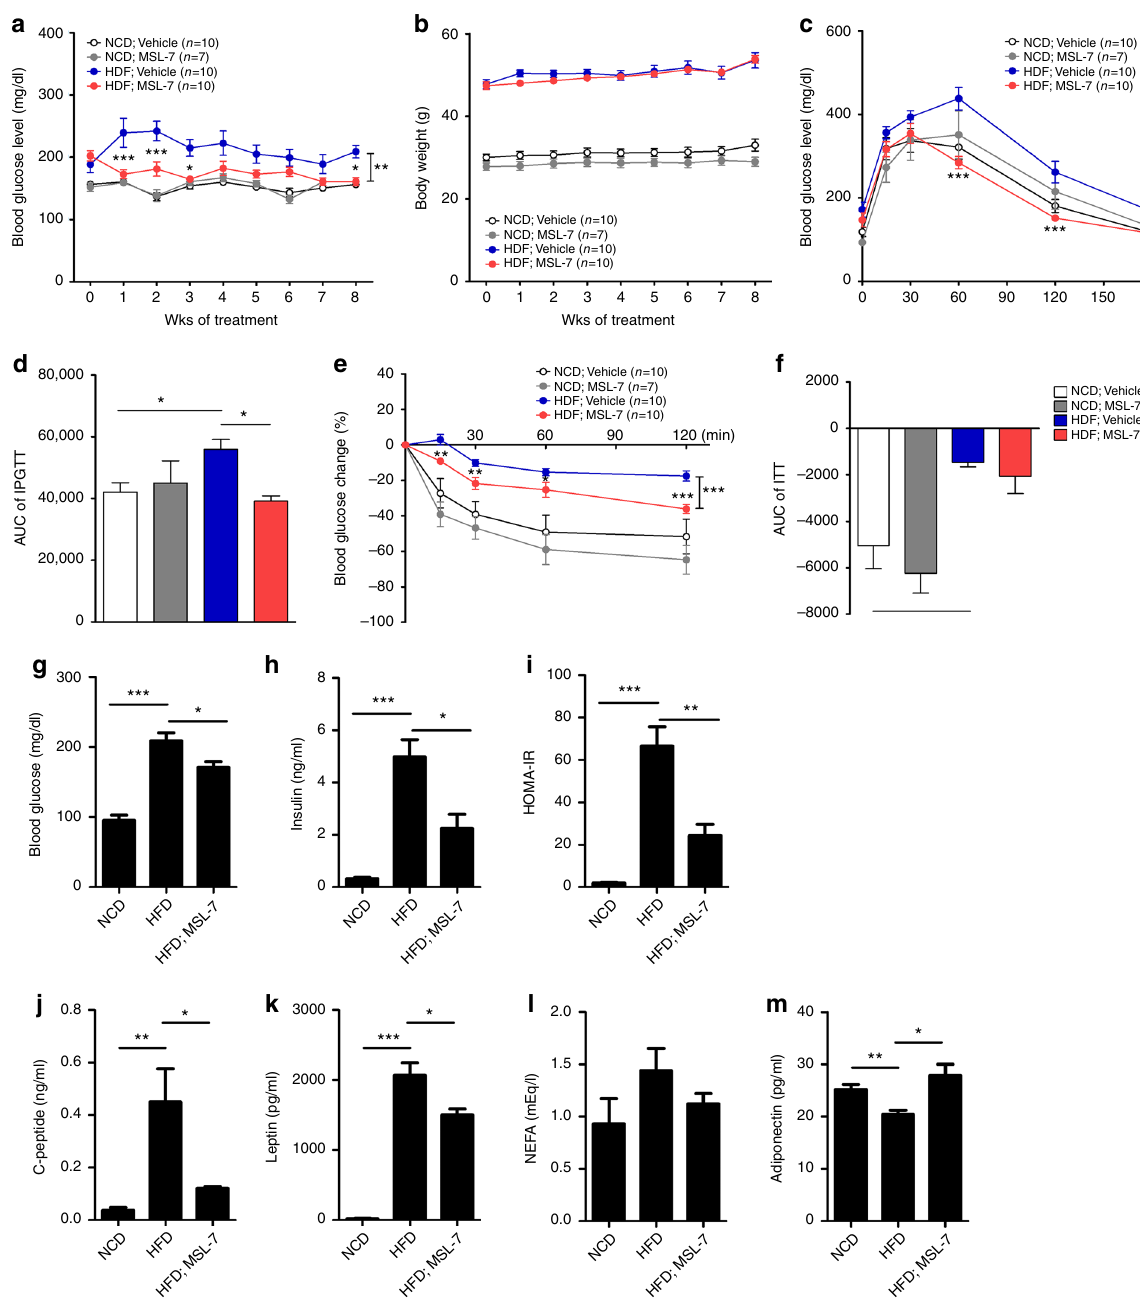
Fig. 6 Improved metabolic pro fi le of HFD-fed mice after administration of chemically modi fi ed autophagy enhancer, MSL-7. a , b Eight-week-old male C57BL/6 mice were fed HFD or normal chow diet (NCD) for 8 weeks, and then treated with 50 mg/kg MSL-7 3 times a week for 8 weeks. Nonfasting blood glucose level ( a ) and body weight ( b ) were monitored ( F = 56.5, df = 1 for a ). c IPGTT was conducted after in vivo administration of MSL-7 for 8 weeks ( F = 52.7, df = 1). d AUC of the IPGTT curve in c ( F = 4.2, df treatment = 3, df residual = 33). e ITT was conducted after in vivo administration of MSL-7 for 8 weeks ( F = 52.6, df = 1). f AUC of the ITT curve in e ( F = 10.3, df treatment = 3, df residual = 33). g – m Metabolic parameters of mice treated with MSL-7. Fasting blood glucose level ( g ) and serum levels of insulin ( h ), C-peptide ( j ), leptin ( k ), NEFA ( l ), and adiponectin ( m ) were determined. HOMA-IR was calculated ( i ). All data in this fi gure are the means ± s.e.m. from ≥ 3 independent experiments performed in triplicate. * P < 0.05, ** P < 0.01 and *** P < 0.001 by two-way ANOVA with Bonferroni ’ s post-hoc test ( a , c , e ), one-way ANOVA with Tukey ’ s post-hoc test ( d , f ) or two-tailed Student ’ s t